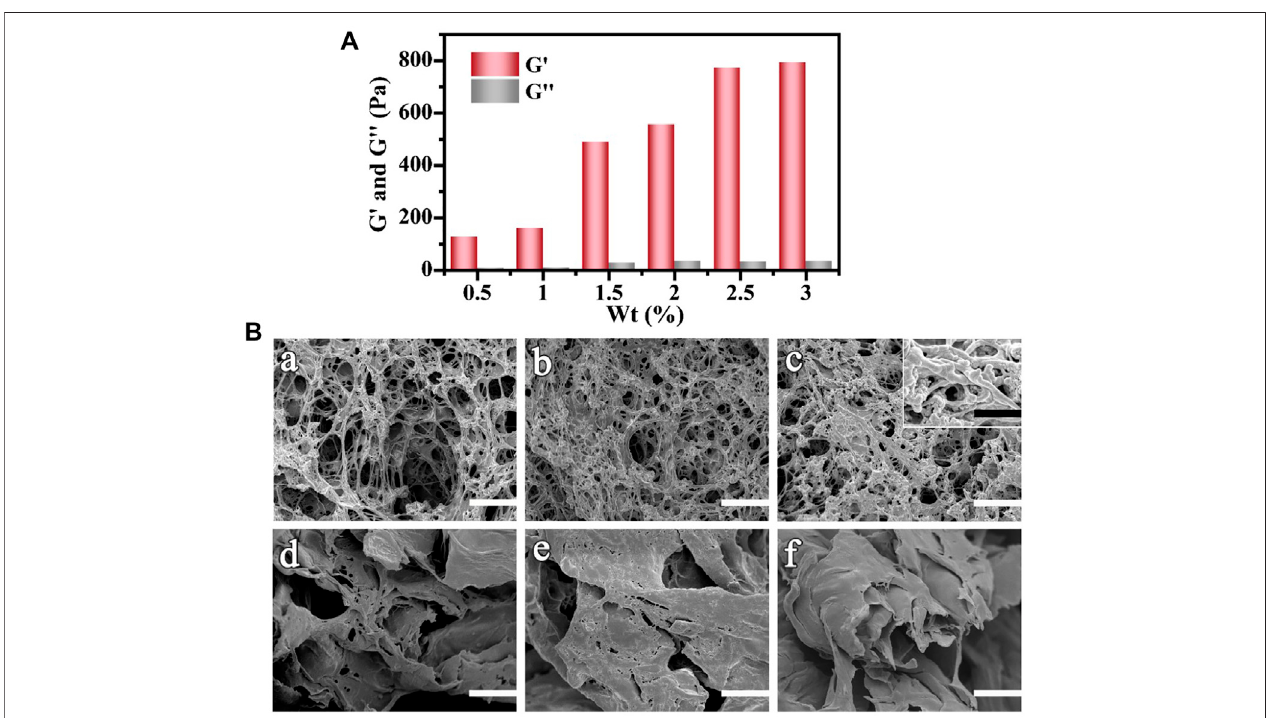
FIGURE 2 | (A) G ′ and G ″ vs. the concentration of gelatin increases from 0.5 to 3 wt%. (B) SEM images of Ag NPs/CPH material with different amounts of gelatin content (a) 0.5 wt%, (b) 1 wt%, (c) 1.5 wt%, (d) 2 wt%, (e) 2.5 wt%, and (f) 3 wt%.